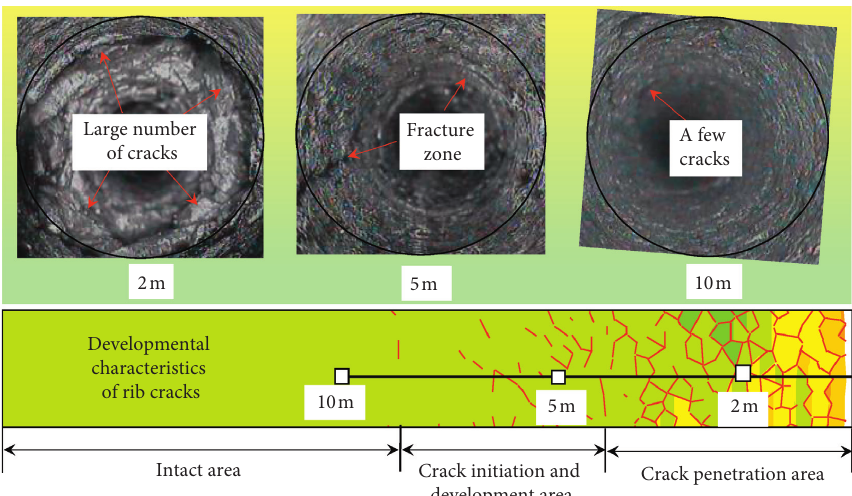
Figure 8: Comparison of crack development characteristics of chamber between numerical simulation and field measurement.